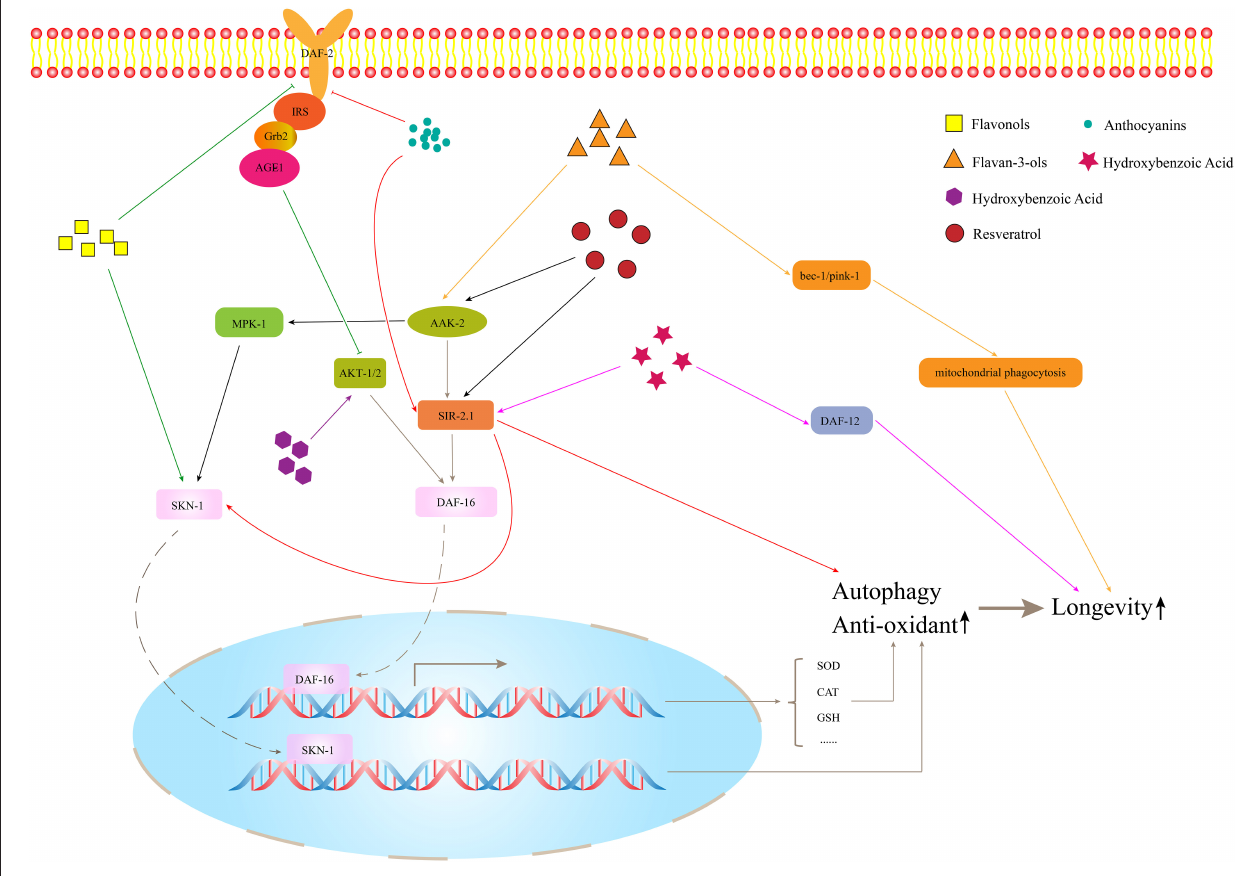
FIGURE 2 | The effects of polyphenols on